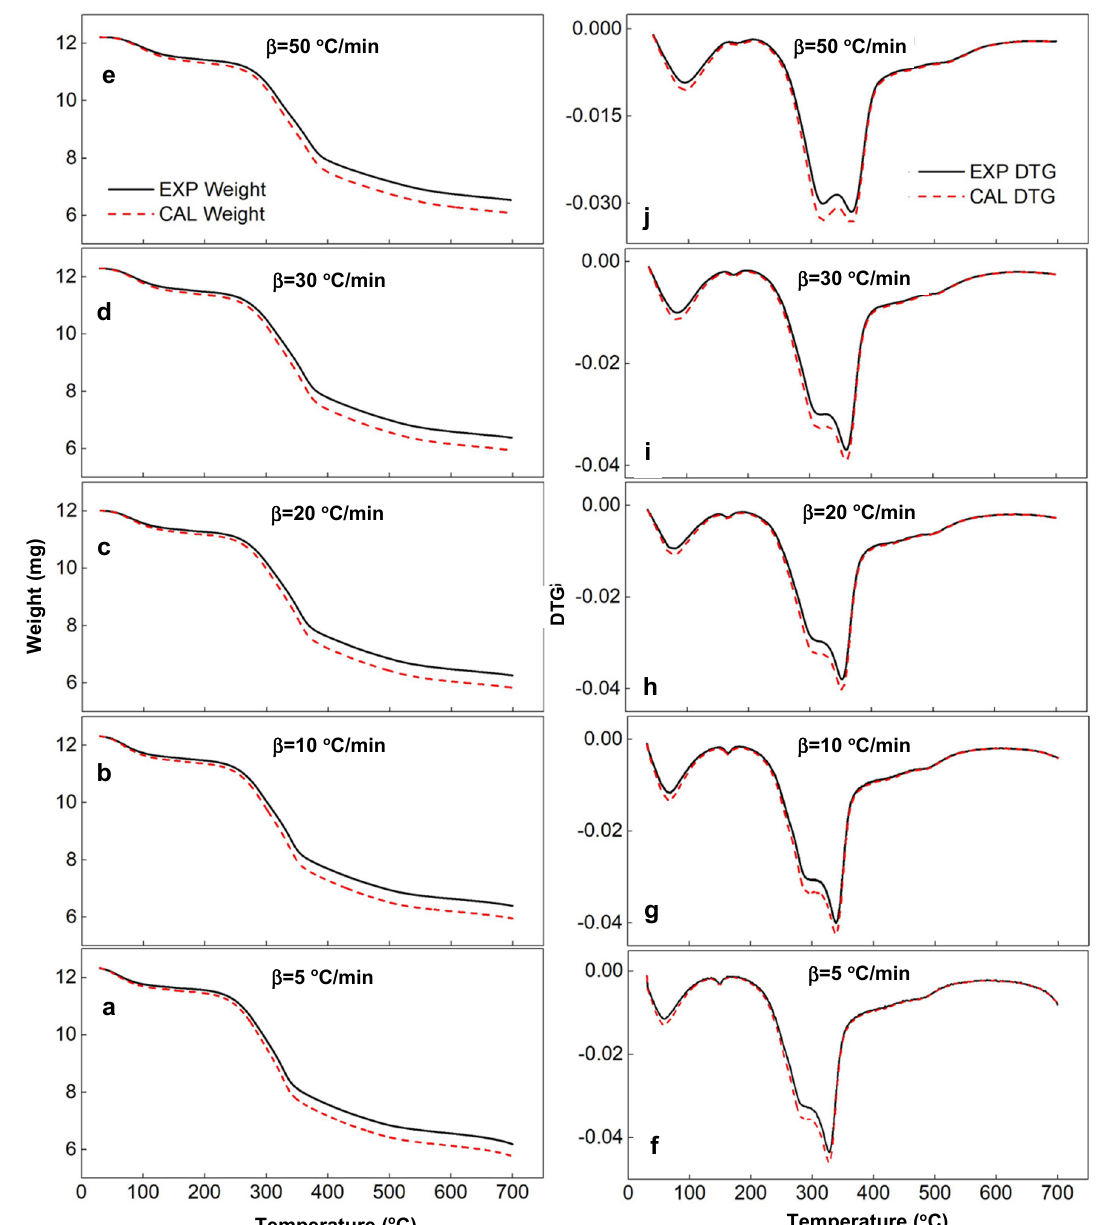
Figure 9. TG (left column: ( a – e )) and DTG (right column: ( f – j )) curves of different heating rates based on the calculated optimized parameters and experimental data.